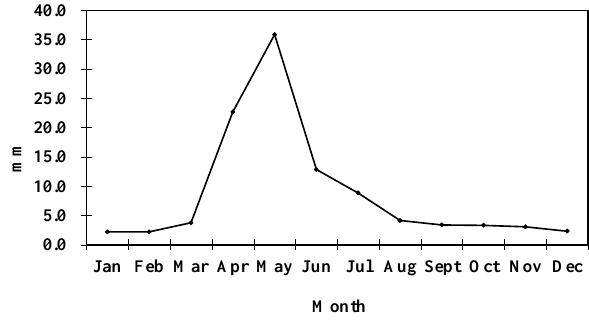
Figure 3 Average monthly flow in the Baker Creek watershed 937 Fig. 3. Average monthly flows in the Baker Creek